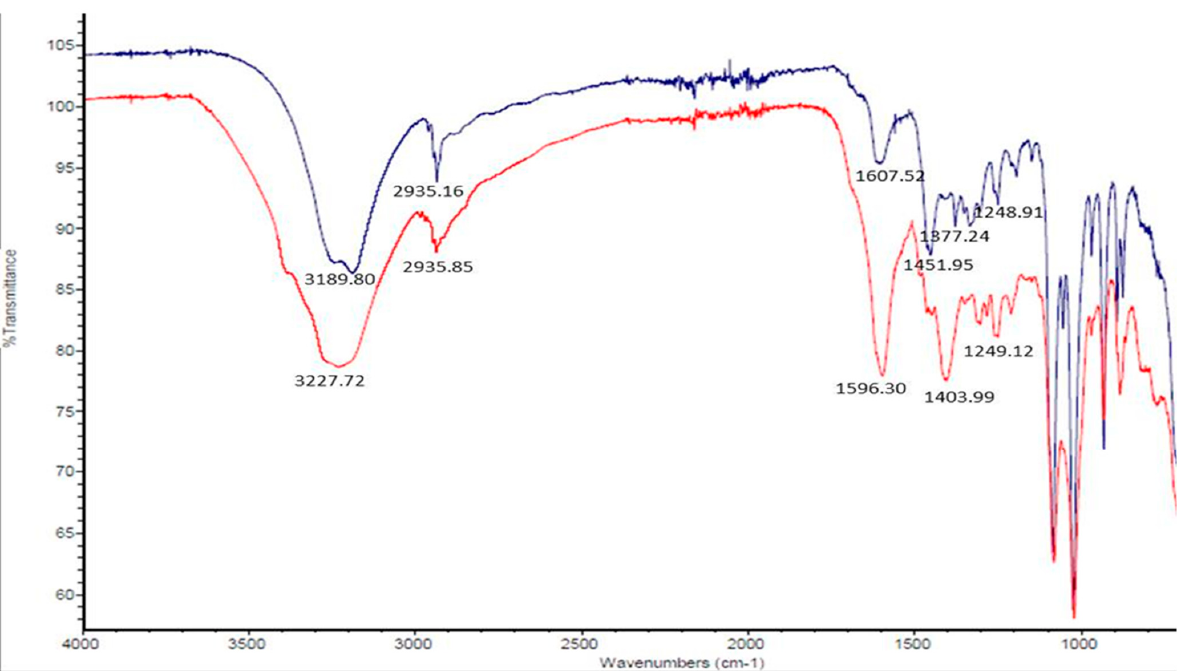
Figure 2. The FTIR analysis of isometamidium chloride-loaded alginate gum acacia nanoformulation (ISM SANPs: red) and unloaded alginate gum acacia nanoformulation (blue).